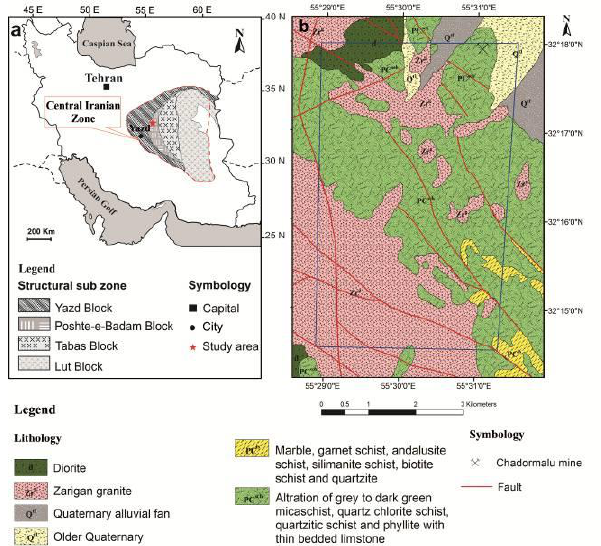
Fig. 1. a. Iran map with simplified structural subzone of central Iran (after aghanabati, 1998) and location of Chadormalu area, dashed red line shows the approximate region of central Iranian zone. b. Geological map of study area, modified after 1:100000 geological map of Ariz (Majidi and babakhani, 2000) and 1:100000 geological map of Chadormalu (Ghaemi and Saidi, 2006). The WV-3 area of interest (AOI) is restricted to blue Fig. 2. Landscape views of rock units and alteration at borderline. Chadormalu area, central Iran. a. View of green schist, granite and diorite in the study area from an elevation of about 2000 meters above sea level. b. Southern to western part view of Chadormalu iron-apatite mine with albitization and actonilitization alteration zones. c. Zarigan granite with cover of desert